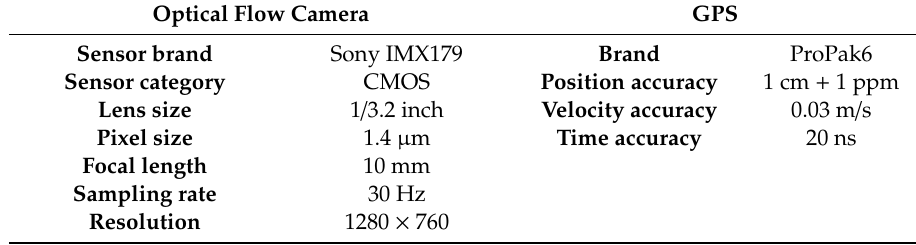
Table 2. Parameters of experimental equipment.